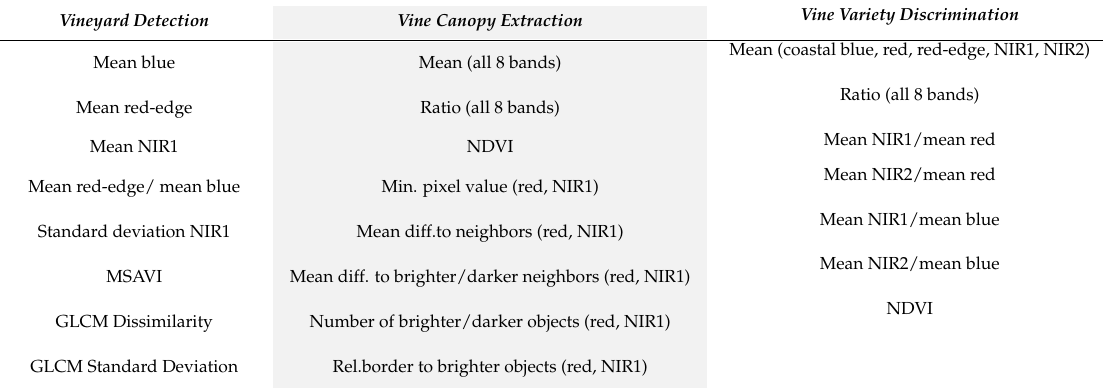
The spectral, spatial and textural features that were associated with the developed rule-set hierarchy for the (i) vineyard detection; (ii) vine canopy extraction and (iii) vine variety discrimination tasks. Vineyard